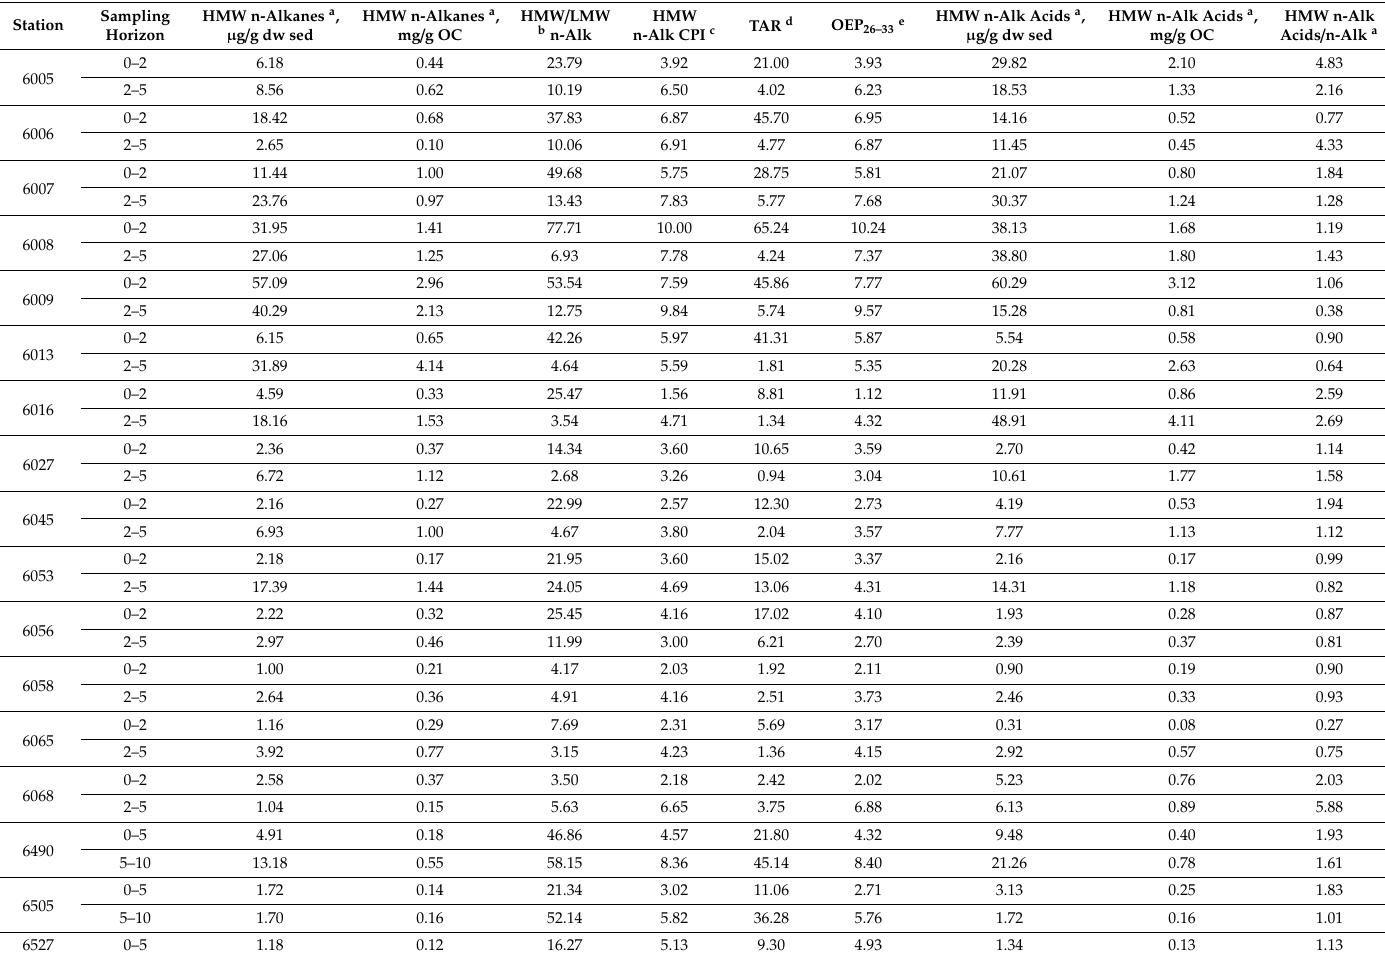
Table 3. Molecular markers of the LS surface